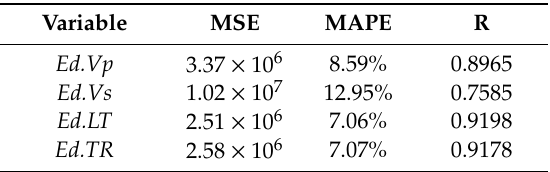
Figure 9. Comparison of individual Ed and Ec values. Table 5. Analysis of correlation between predicted Ec and measured Ec using general regression for each variable.